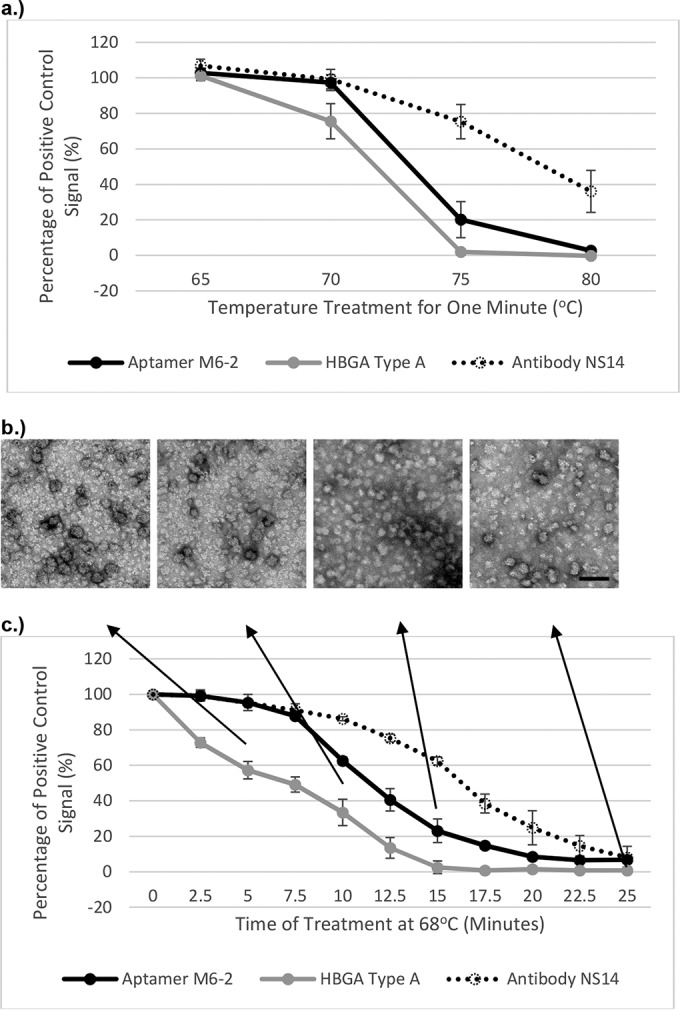
Conformation-dependent binding of three different ligands to SYV VLPs treated at selected time-temperature combinations. (a) Signals of aptamer M6-2, HBGA type A, and antibody NS14 binding to SYV VLPs treated at various temperature for 1 min are reported as percentages of signals of binding to untreated VLPs. (b) TEM images of SYV VLPs treated at 68°C for 5, 10, 15, or 25 min. The scale bar represents 100 nm. (c) Signals of aptamer M6-2, HBGA type A, and antibody NS14 binding to SYV VLPs treated at 68°C for various times are reported as percentages of signals of binding to untreated SYV VLPs.